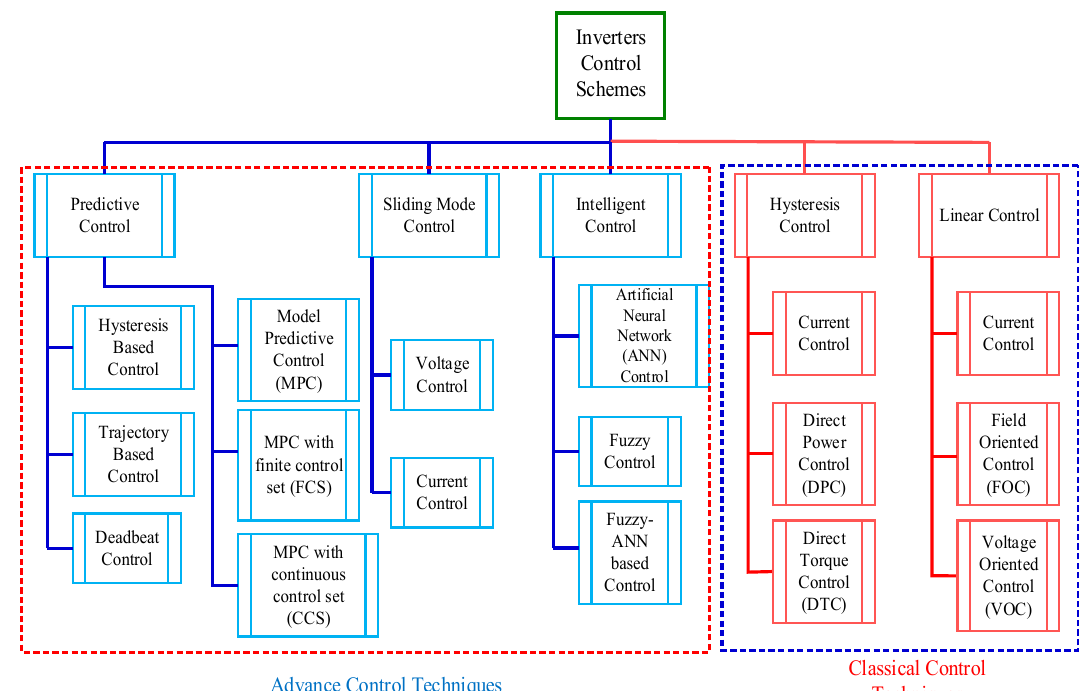
Figure 19. Classification of control techniques for VSIs.